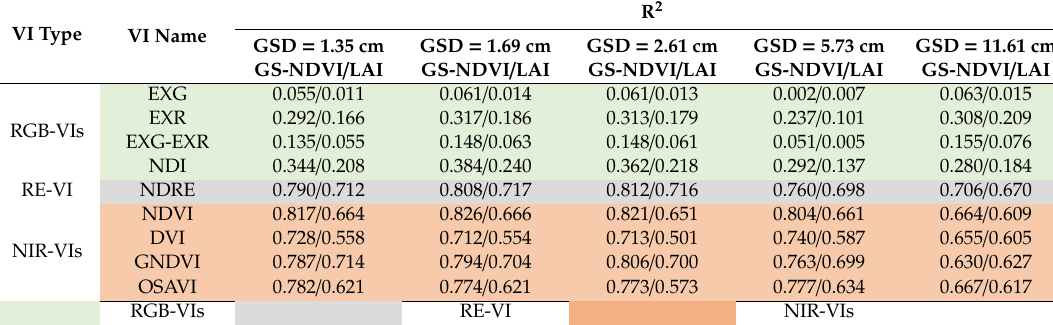
Table 4. Coefficients of determination between ground-measured parameters (GS-NDVI and LAI) and nine UAV-VIs 1 .